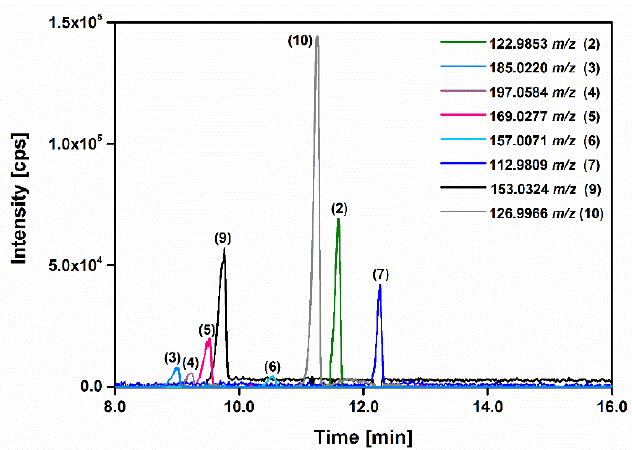
Figure 6. Electropherogram of the OPs in the aged electrolyte sample containing DEP (9) and PS.